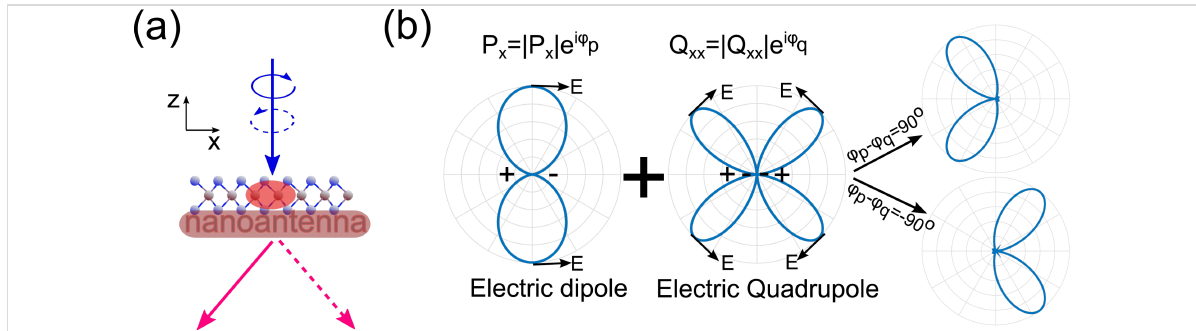
Figure 1: Design principles of the directional emission from the different TMDC valleys. (a) The proposed scheme to separate emission from different valleys through integrating with a properly designed nanoantenna. The directions of the emission from monolayer TMDCs depend on the polarization states of the excitation when different valleys are excited. (b) The working principle of the nanoantenna is based on the interference between the elec- tric fields radiated from an electric dipole and an electric quadrupole; the direction of constructive interference depends on their relative